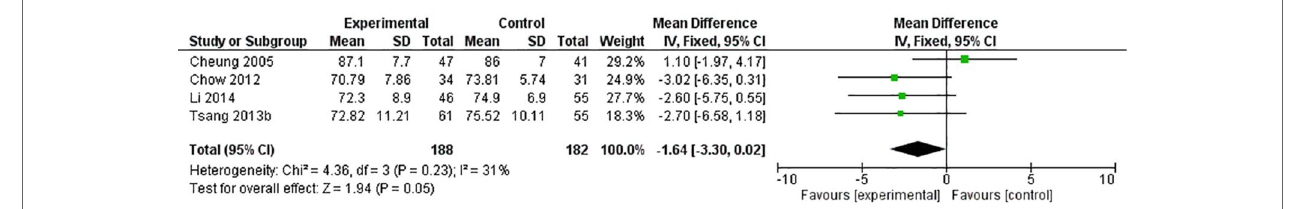
FiGURe 4 | Forest plot of diastolic blood